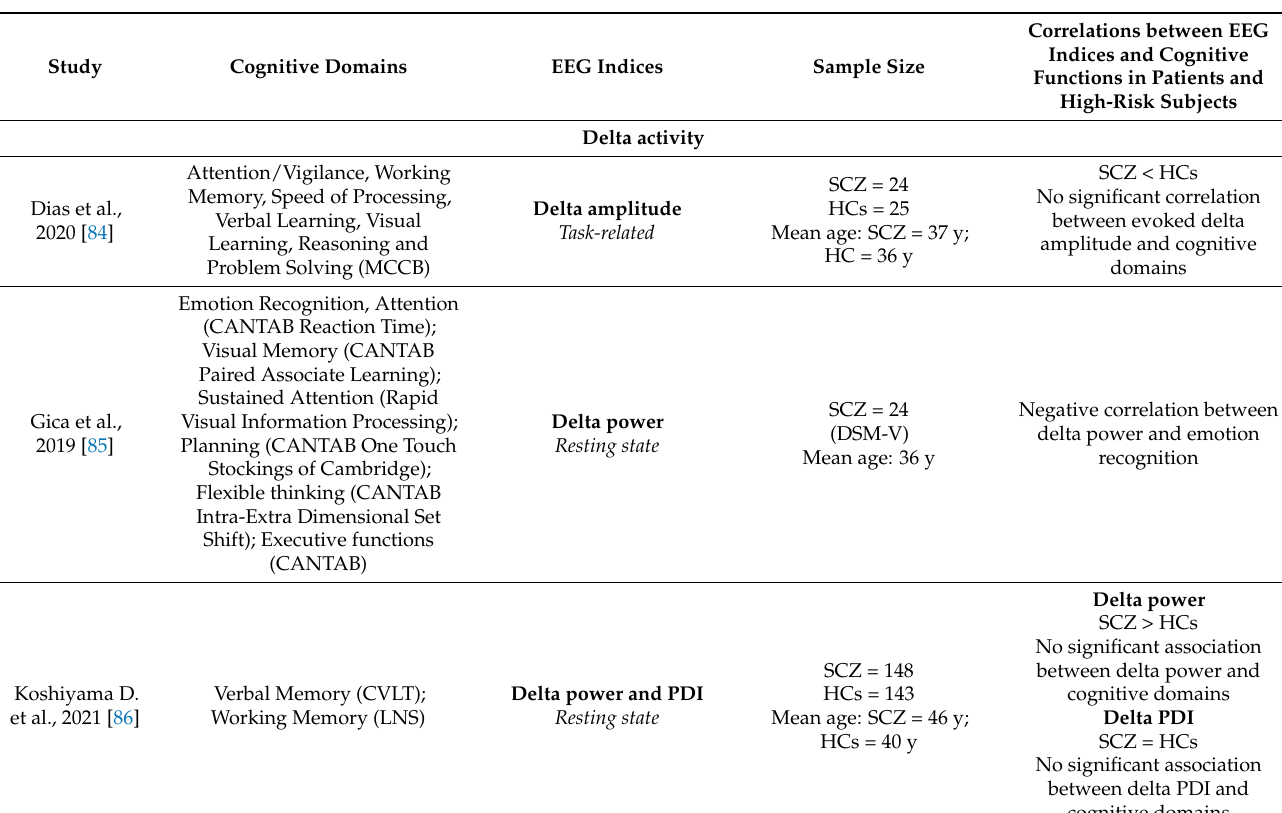
Table 2. Frequency bands activity